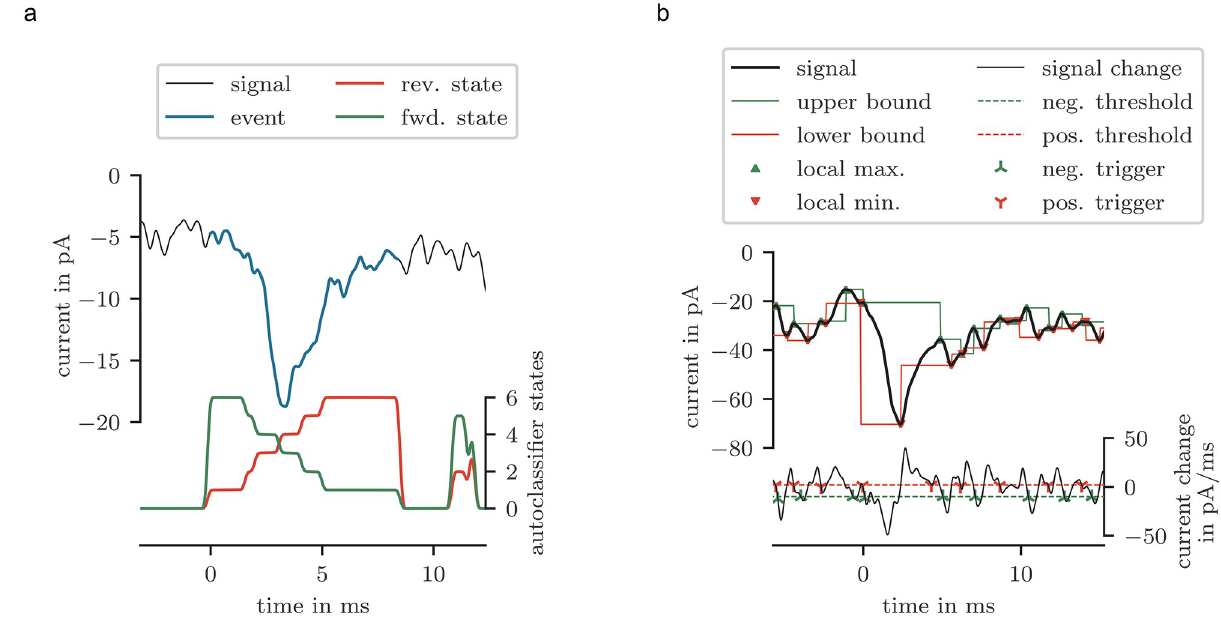
Fig 7. Examples of event detection with autoclassifier and threshold based